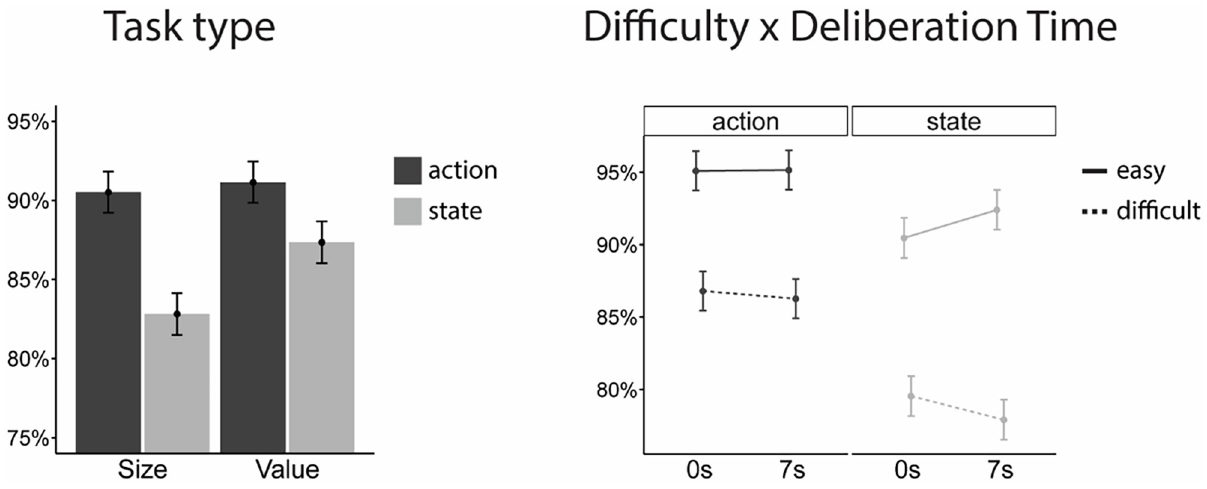
Fig 4. Group differences in confidence magnitude. Error bars represent standard errors across